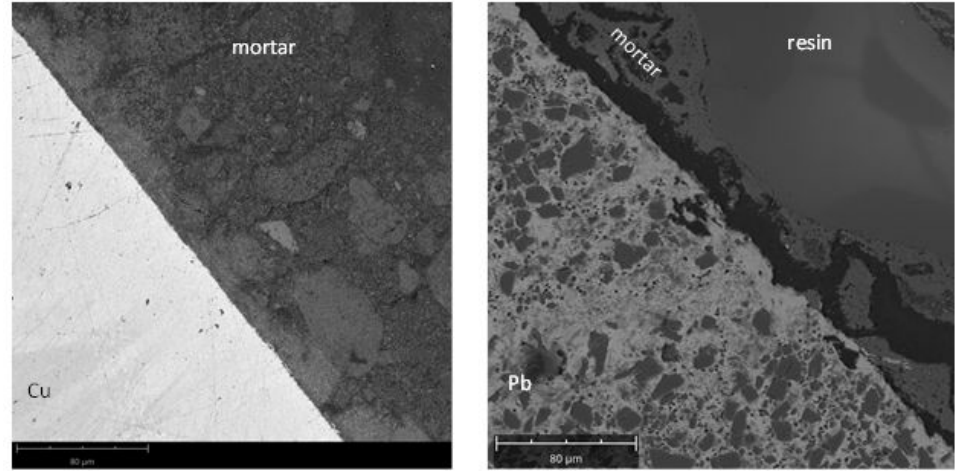
Figure 3. Interface of copper (left) and lead (right) with lime mortar.